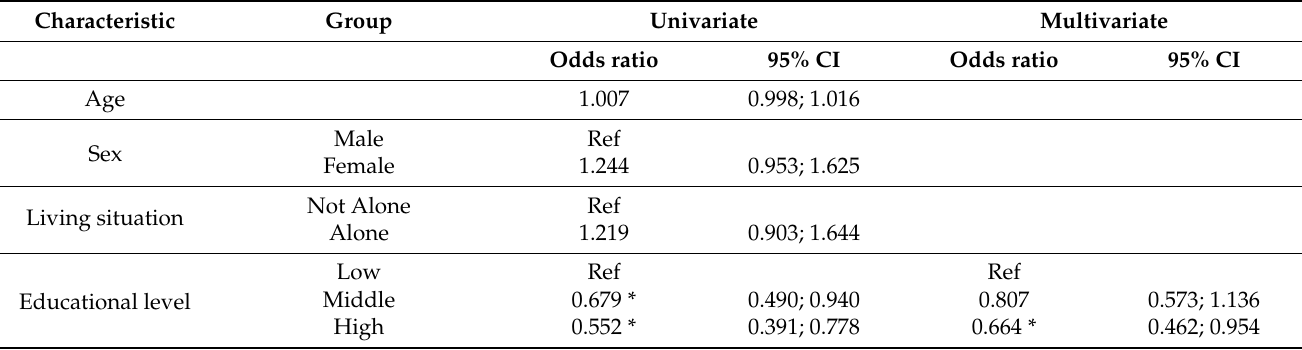
Table 2. Characteristics of the study population and comparison between patients with and without post-concussion syndrome ( ≥ 3 of the core post-concussion symptoms).